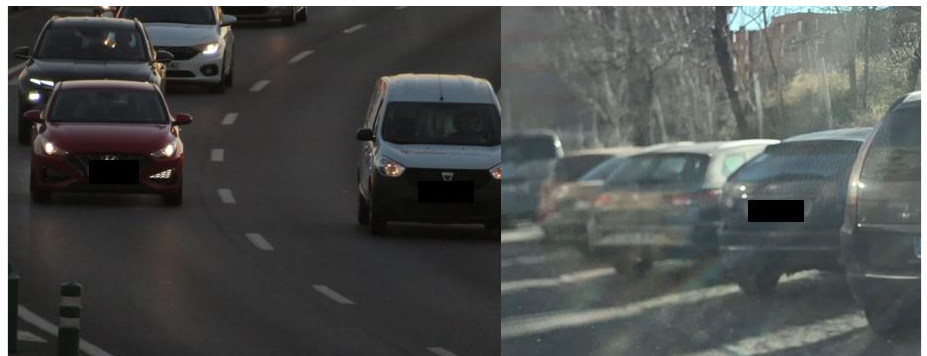
Figure 14. Spanish ALPR Dataset examples.